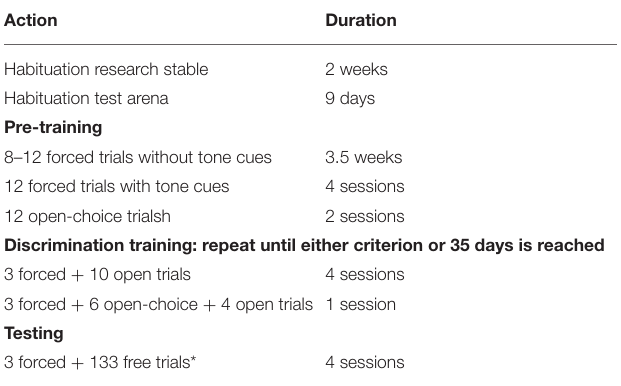
TABLE 2 | Overview of JBT